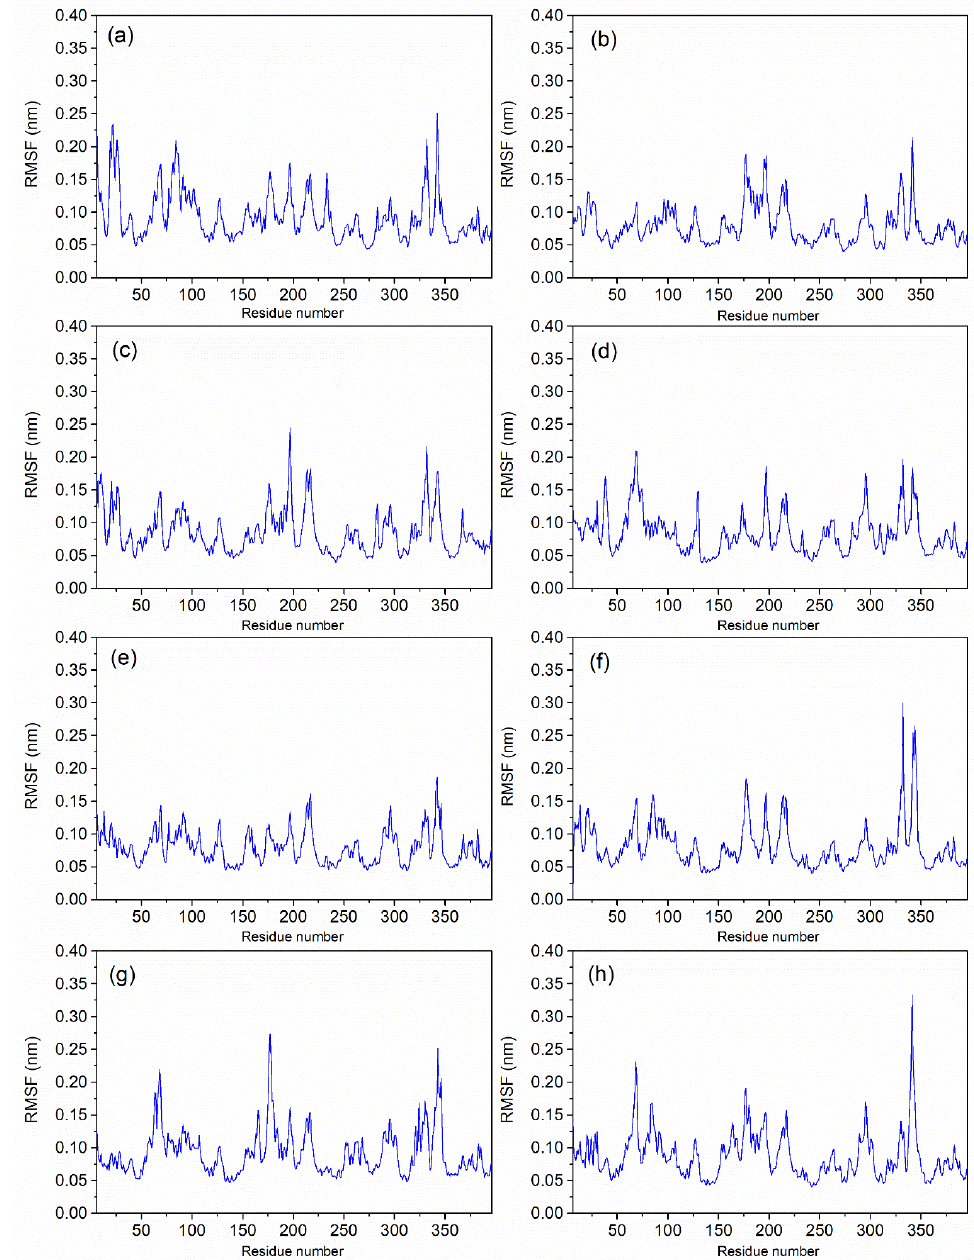
Figure 3. RMSF plots of protein with all ligands ( a ) Catechin 3,7,-Di- O -Galate, ( b ) Catechin 5,7,-Di- O -Gallatec, ( c ) Catechin 5,4’ -Di- O -Gallate, ( d ) Epifisetinidol-(4beta->8)-Catechin, ( e ) Catechin 3- O -Rutinoside, ( f ) Epicatechin (4b->6) Catechin, ( g ) reference L44 inhibitor, and ( h ) apo-protein.